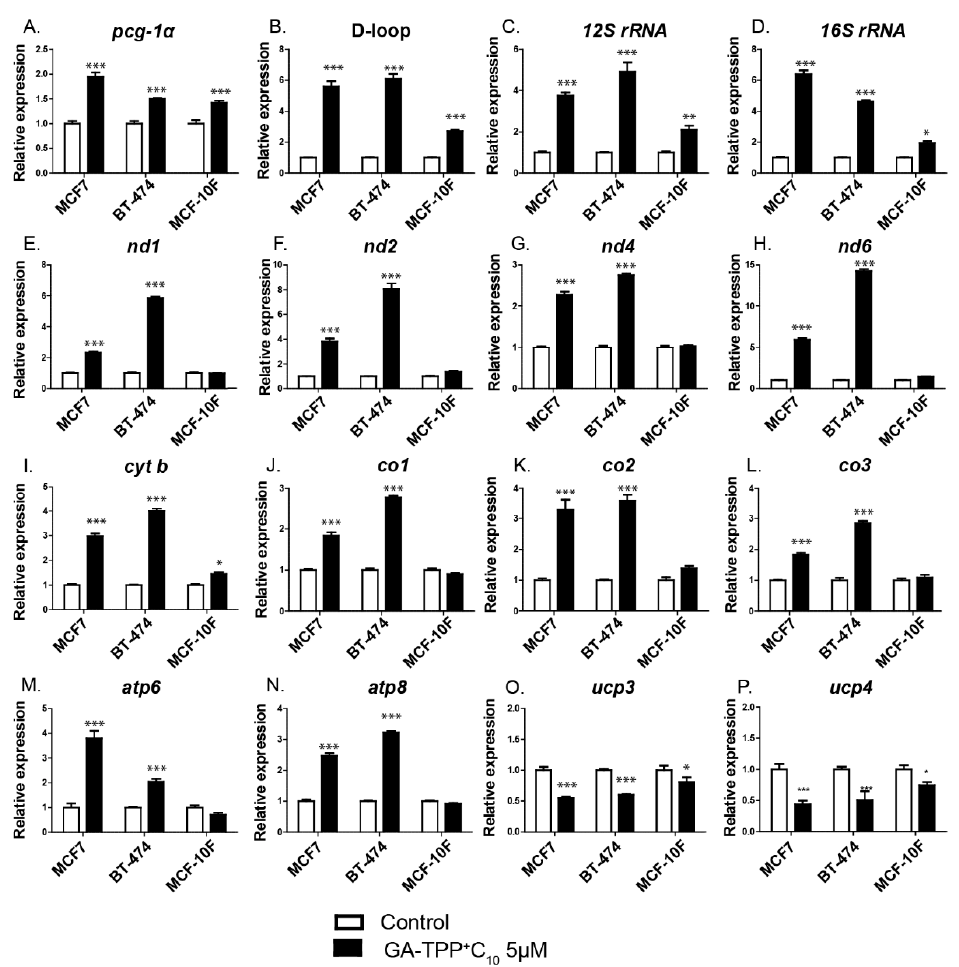
Figure 6. The effect of GA-TPP + C 10 increases mitochondrial biogenesis-related gene expression in BC cells. ( A – N ) Changes in the expression of genes related to mitochondrial biogenesis and ( O , P ) uncoupling proteins ( ucp s) induced by GA-TPP + C 10 in the BC cells after 24 h of exposure. Values are expressed as the mean ± SEM of five independent experiments. * p < 0.05, ** p < 0.01, *** p < 0.001 vs. the control